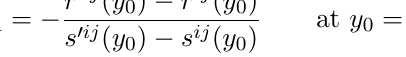
Table 2 . Results of the individual improvement condition runs along the LCP for various input values of c sw . Beside g 0 , (cid:20) l and (cid:20) c , we quote the corresponding current quark masses m ud ( x 0 ) at x 0 = T (cid:3) = 2 with one-loop c , the improvement condition mass M ud ( x 0 ; y 0 ) for x 0 = 1 A y 0 = 3 T (cid:3) , and the mass di(cid:11)erence (cid:1) M ud from eq. (5.6). Errors from the relation g 2 4